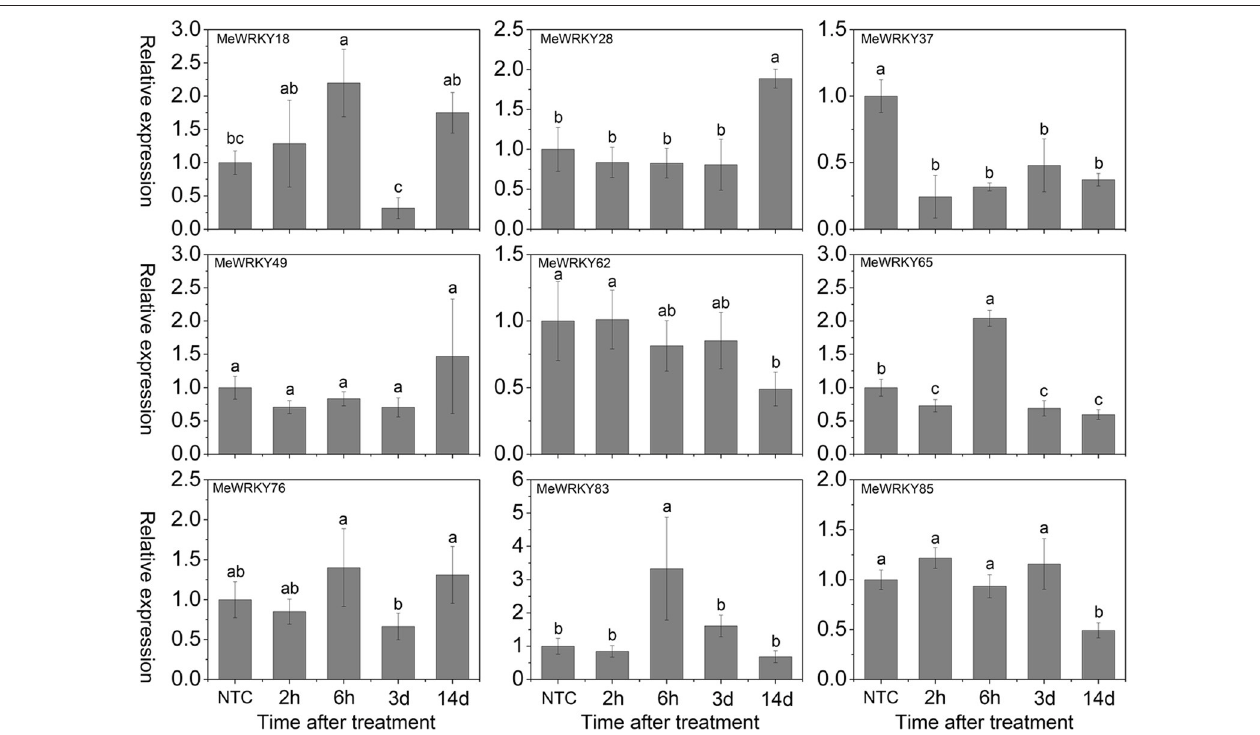
FIGURE 6 | Expression profiles of MeWRKY genes in leaves under salt stress. The relative expression levels of MeWRKY genes in each treated time point were compared with that in each time point at normal conditions. NTC (no treatment control) at each time point was normalized as “1.” Data are means ± SE calculated from three biological replicates. Values with the same letter were not significantly different according to Duncan’s multiple range tests ( P < 0.05 , n = 3